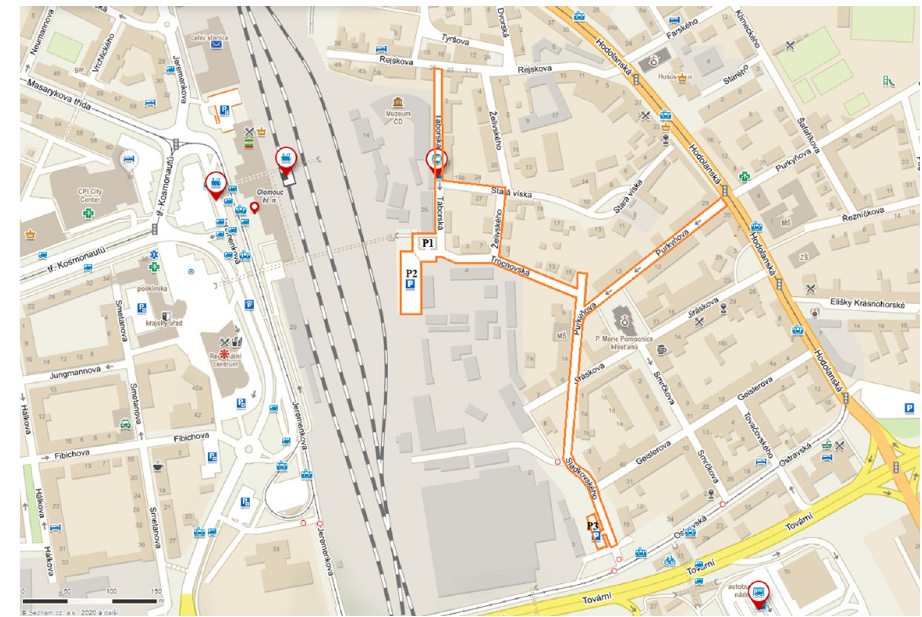
Figure 5: Map of the monitored area Hodolany [ 18 ] .